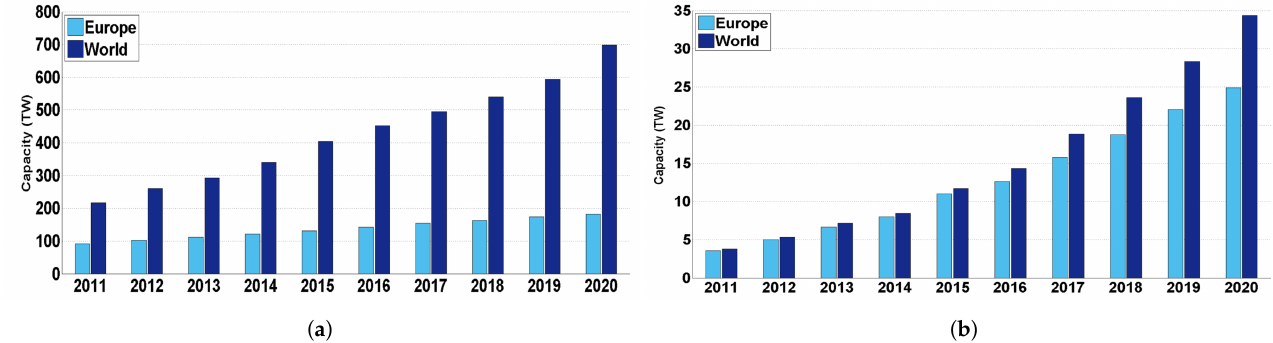
Figure 5. Cumulative installed capacity of wind power in the last ten years in Europe and world [29]: ( a ) Onshore capacity. ( b ) Offshore